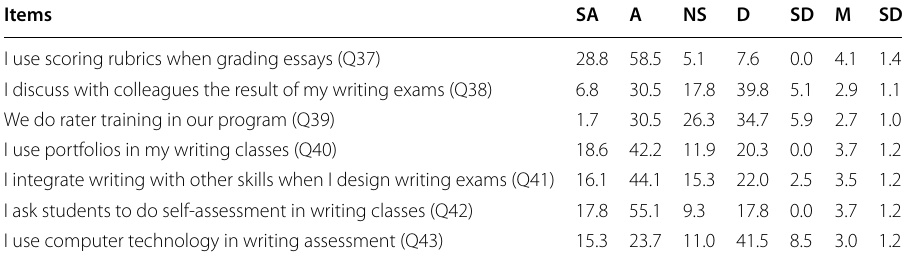
Table 6 Teachers’ actual writing